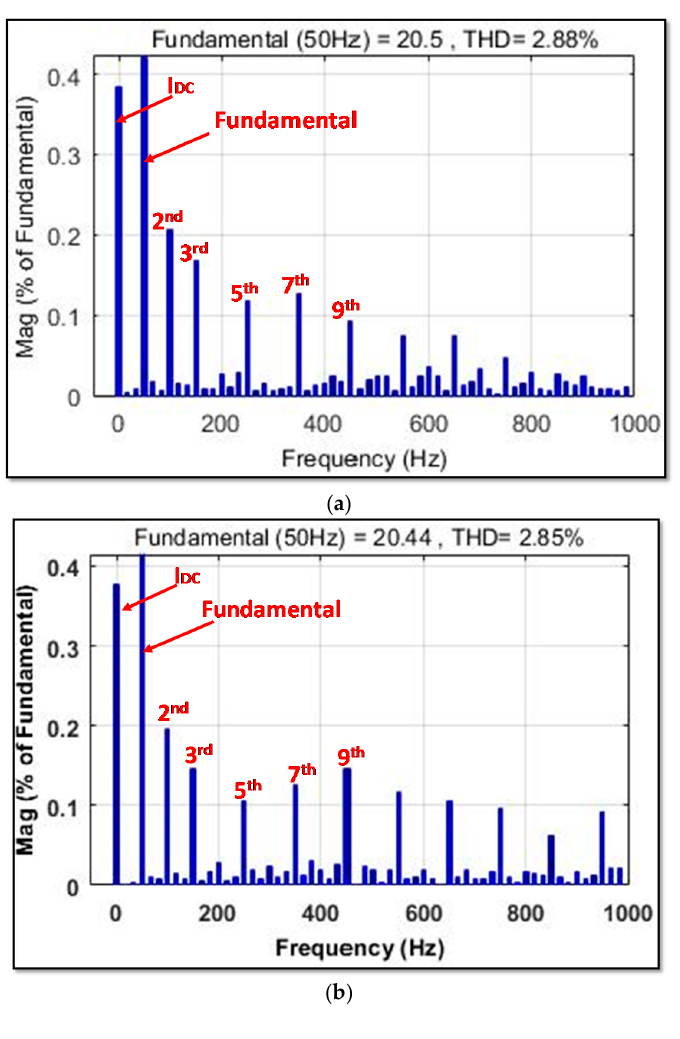
Figure 19. Harmonic content of the grid current for Bipolar Modulation. ( a ) Charging mode; ( b ) Discharging mode.